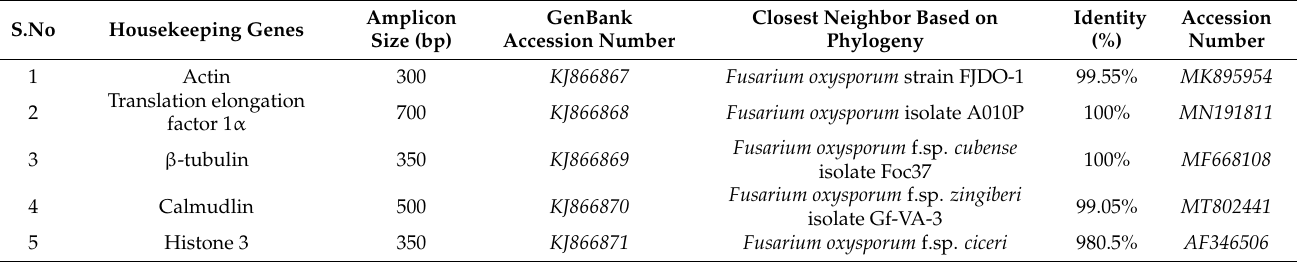
Table 2. List of housekeeping genes used in the present study for the identification of Fusarium oxysporum R1.